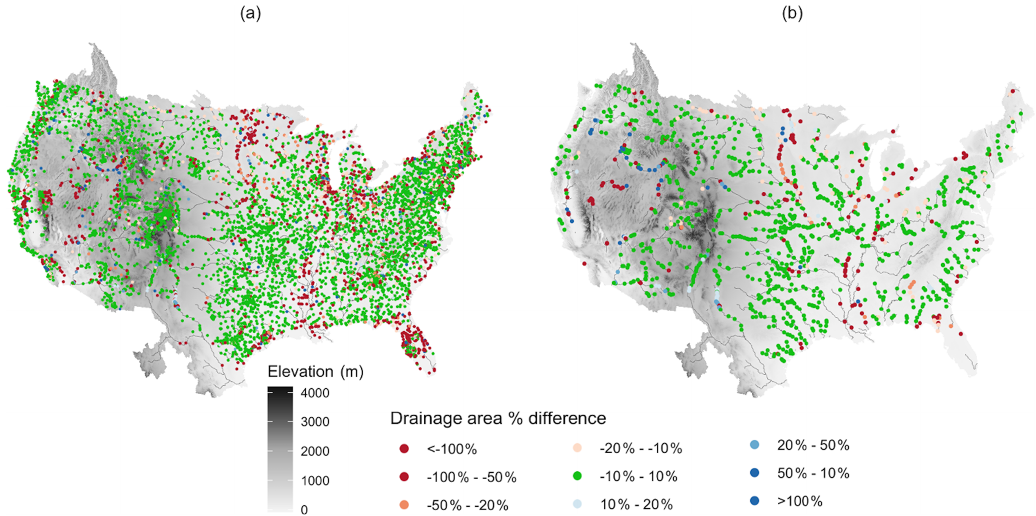
Figure 3. Drainage area comparison between processed with no initial stream network and USGS gage measurements. (a) All gages for comparison; (b) gages with drainage area over 5000km 2 .